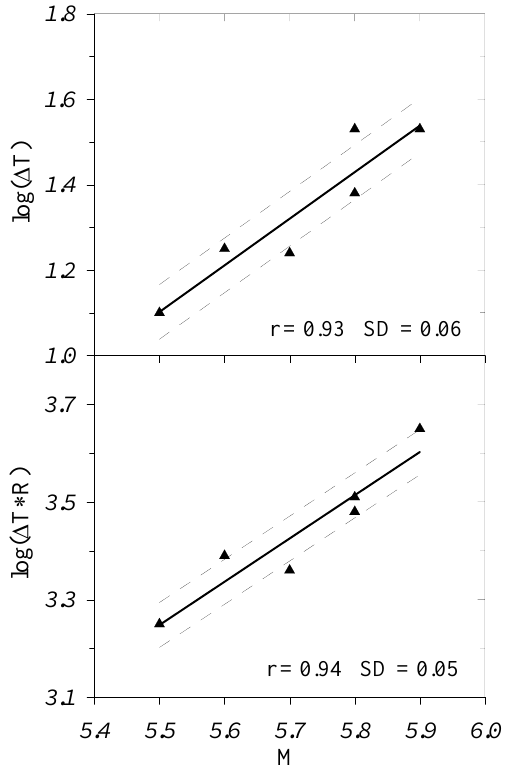
Fig. 4. The observed dependences for log( 1h 0 Es) and log( 1h 0 Es · R ) on the earthquake magnitude. Correlation coeffi- cients ( r ) and standard deviations (SD) are also given. Notice that unlike the 1T case the inclusion of the epicenter distance R does not improve the dependence (bottom panel). Dashes are ± SD. The upper dependence is significant at the 99% confidence level, while the lower dependence is